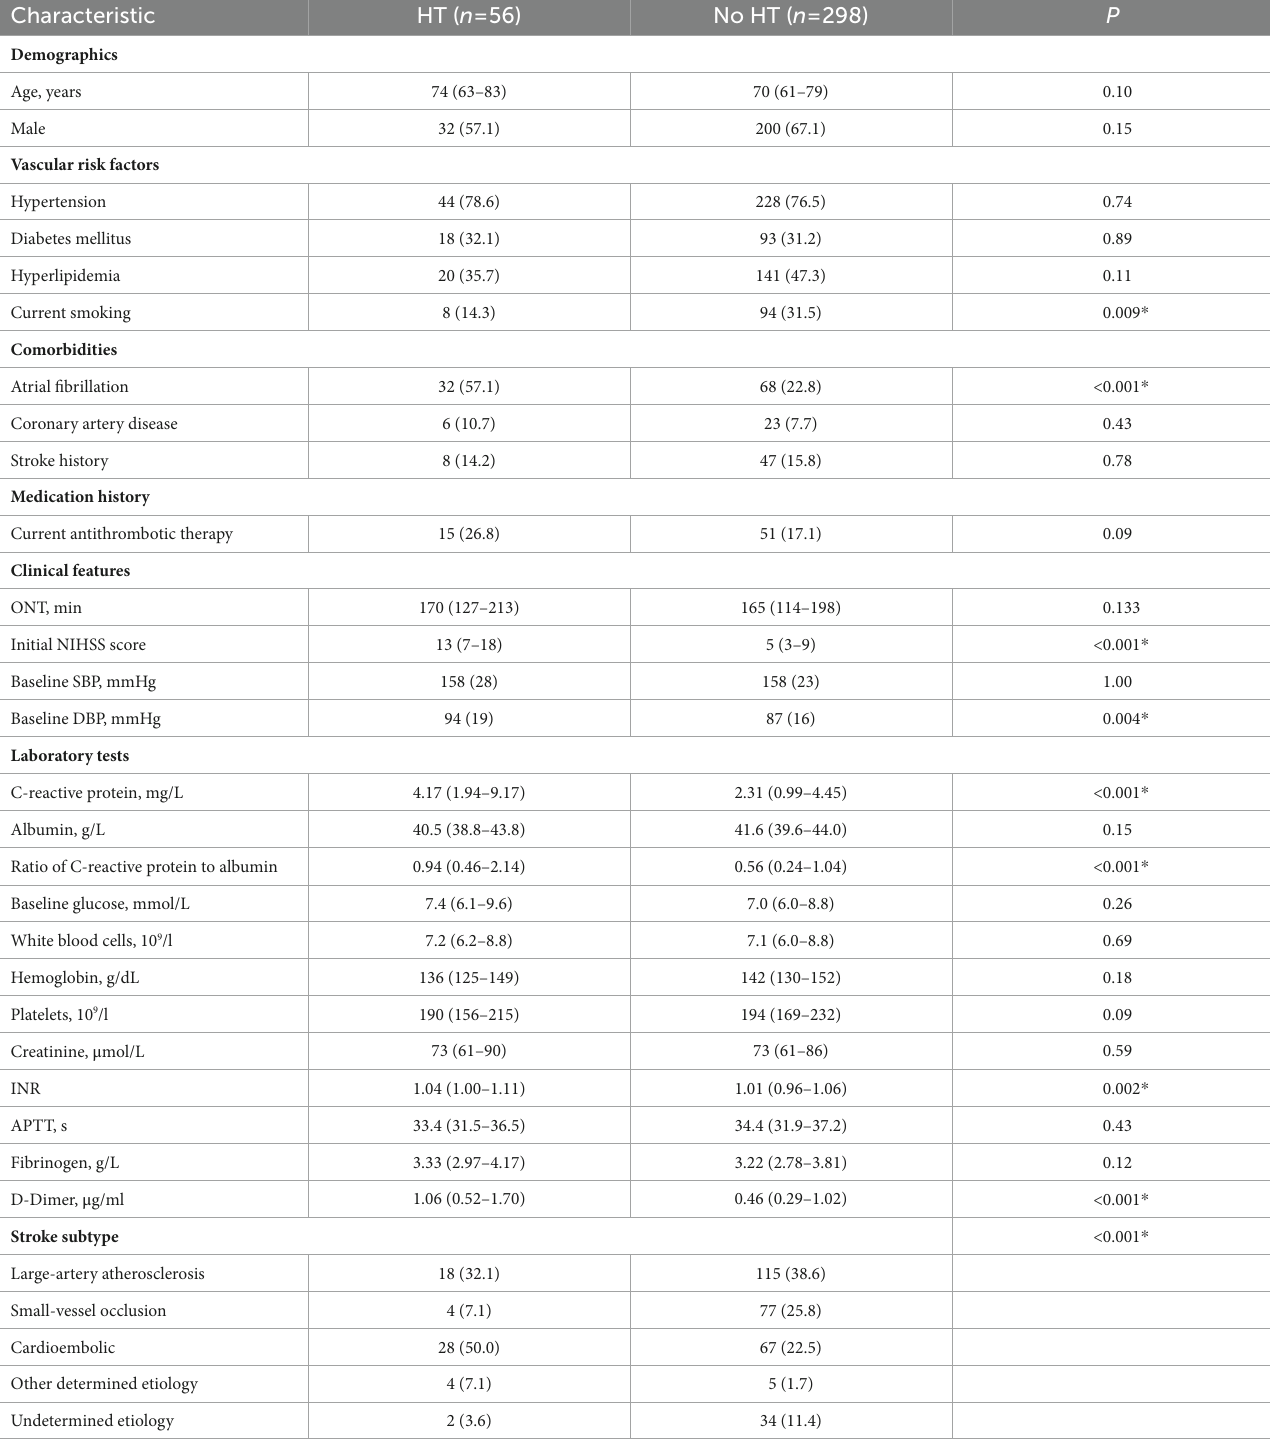
TABLE 1 Comparison of characteristics between patients who experienced HT or not.